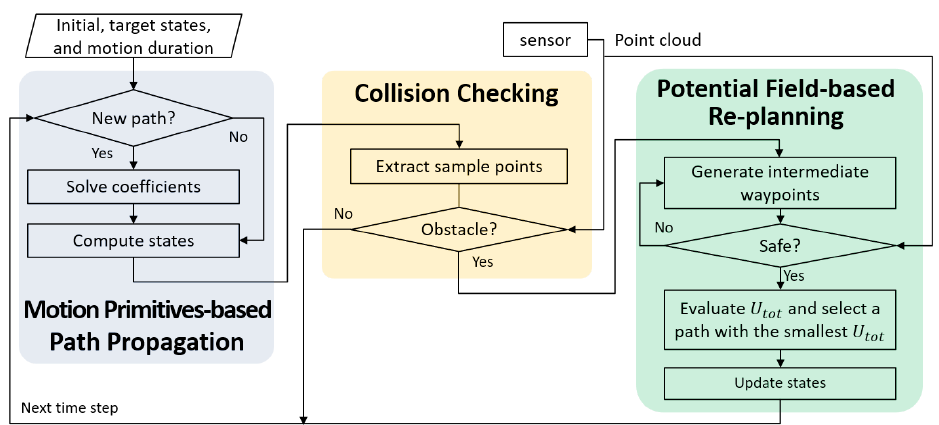
Figure 1. A flowchart of the overall process